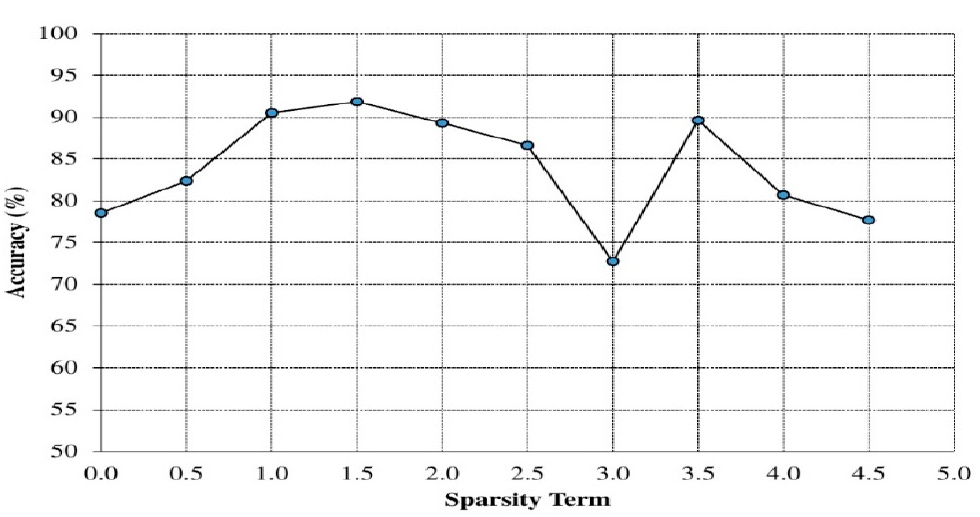
Figure 5. Influence of sparsity term on the performance results.